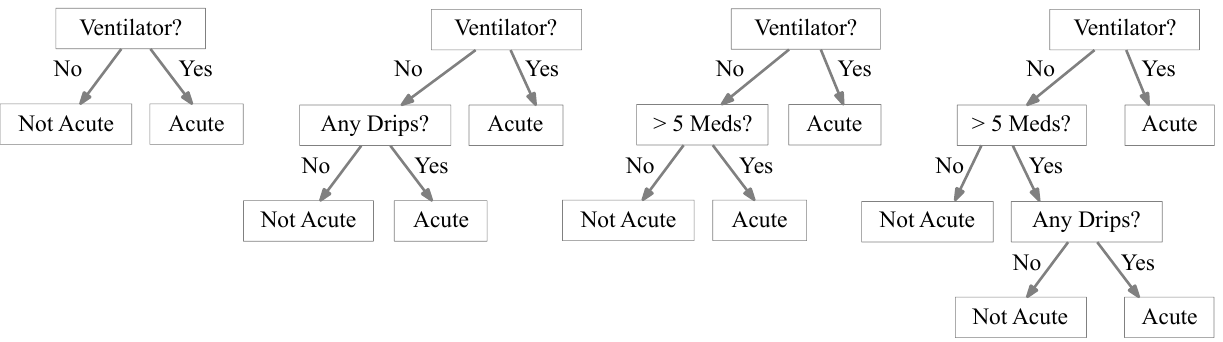
Figure 3. These fast-and-frugal trees heuristically determine whether a patient is acute. As shown in Table 4, they are correct approximately three-fourths of the time, about as often as ordered logistic regression models. Table 5. The number of observations in which each watch variable was listed. Categories not listed in this table had a frequency of zero.